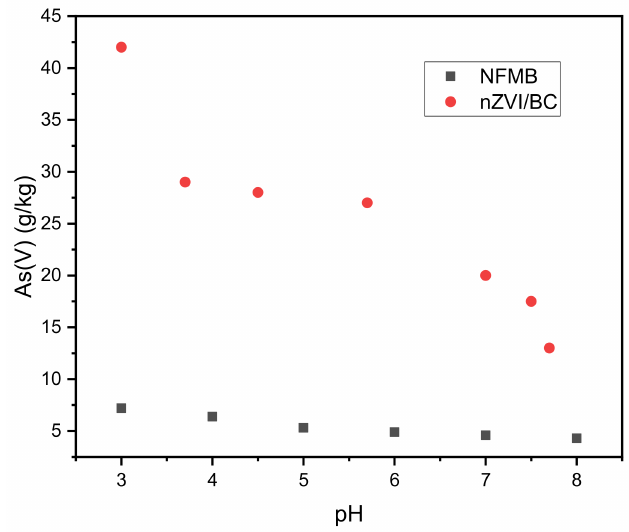
Figure 4. As(V) adsorption as a function of pH variation [123,124]. Table 3. Studies on some natural adsorbent’s reusability